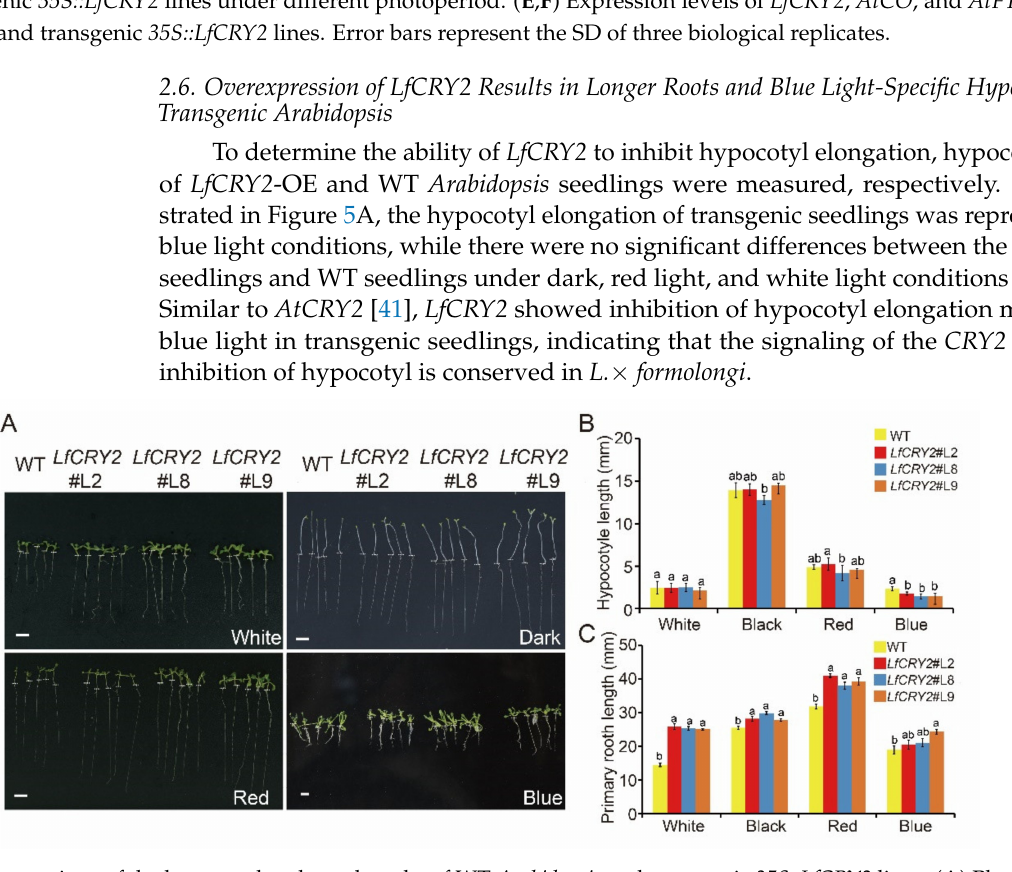
Figure 5. Comparison of the hypocotyl and root lengths of WT Arabidopsis and transgenic 35S::LfCRY2 lines. ( A ) Phenotypes of WT plants and three transgenic lines grown under darkness and blue, white, and red light conditions. The white dashed line indicates the boundary between hypocotyl and root. ( B , C ) Comparison of the hypocotyl and root lengths of WT plants and three transgenic lines grown under darkness and blue, white, and red light conditions. The scale bar represents 5